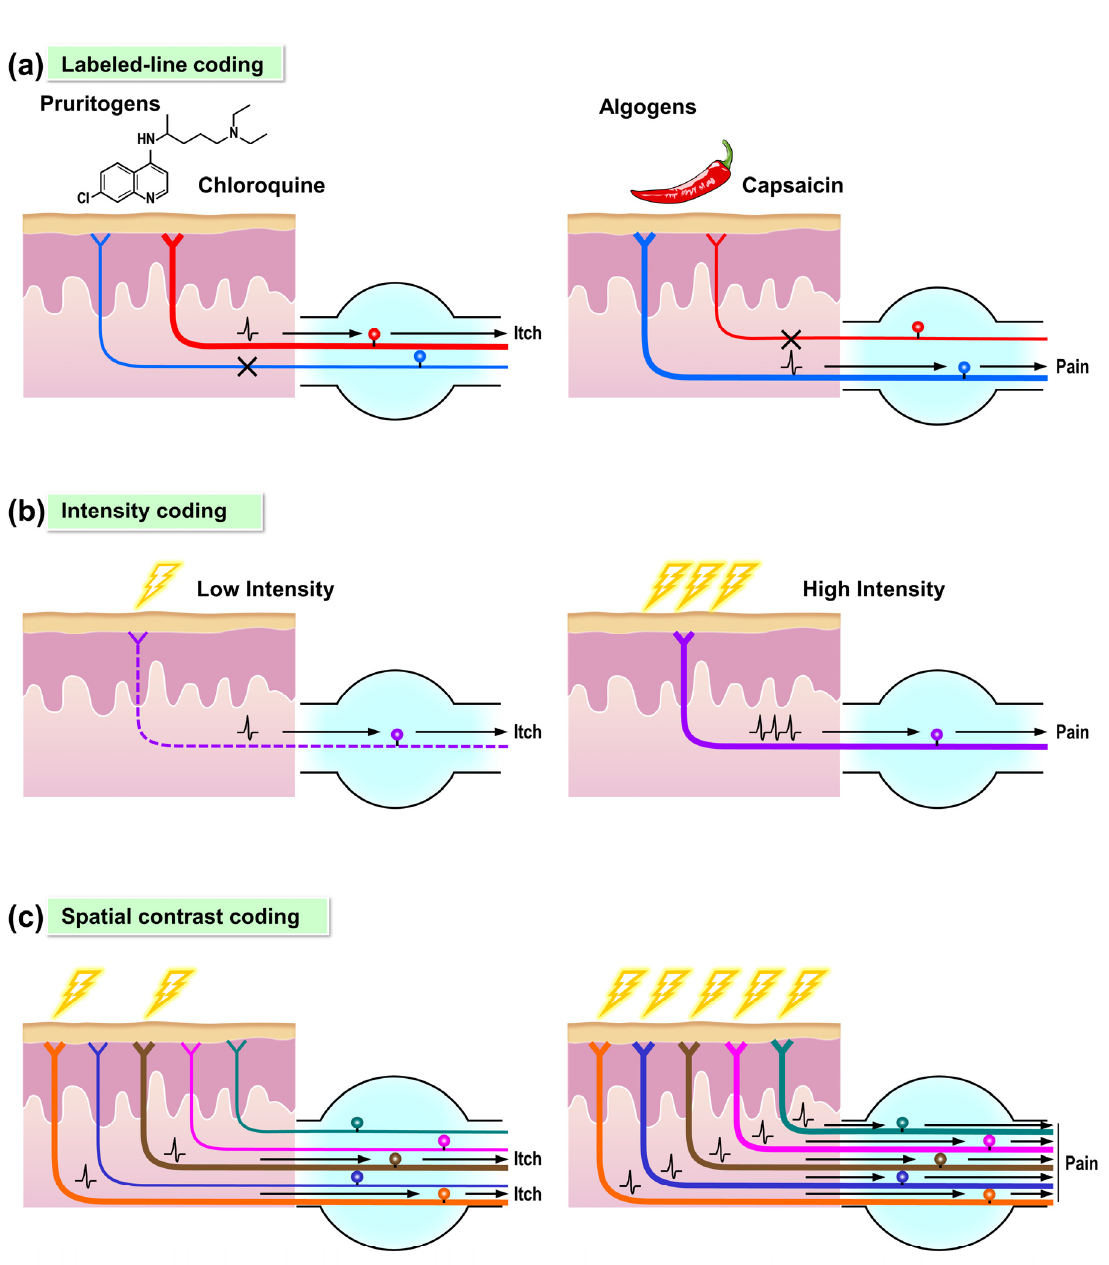
Figure 2. Models of coding for itch and pain. Di ff erent models of coding have been proposed to explain the relationship between itch and pain. ( a ) In the labeled-line coding model, the itch-specific sensory neuron (left) and pain-specific neuron (right) each constitutes a dedicated pathway that only responds to corresponding pruritogens (i.e., chloroquine) or algogens (i.e., capsaicin). ( b ) In the intensity coding model, the itch and pain pathways are comprised of the same population of sensory neurons and circuits. Low-to medium intensity stimuli evoke low firing rates of the sensory neurons and result in itch sensation (left). On the contrary, high-intensity stimuli evoke robust firing rates of the same sensory neurons and result in pain sensation (right). ( c ) In the spatial contrast coding model, focal stimulation of the individual nociceptors induces itch sensation (left). Contrarily, co-stimulation of the same population of sensory neurons with the neighboring nociceptors evokes the pain sensation (right).